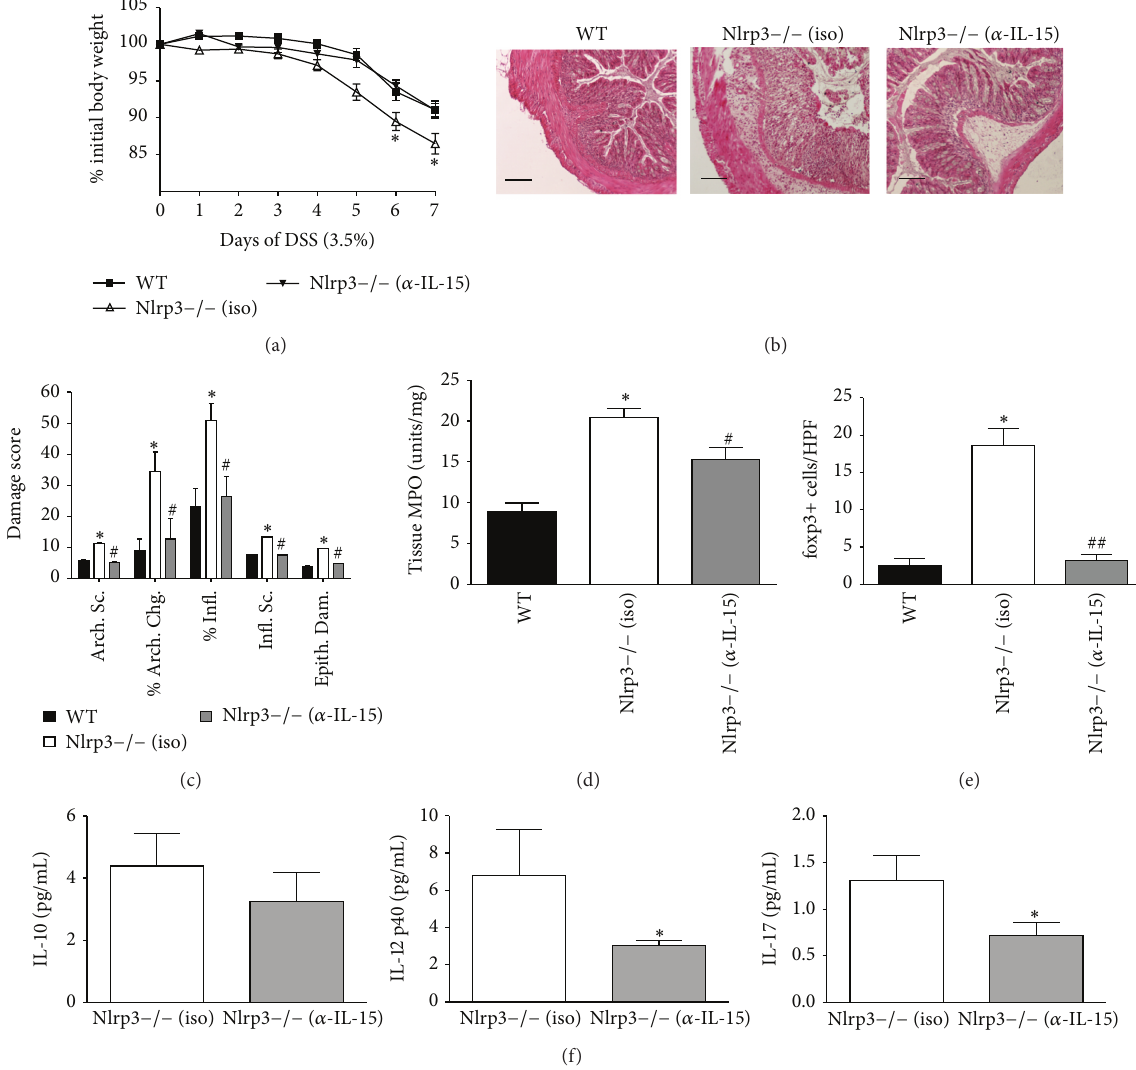
Figure 5: A neutralizing anti-IL-15 antibody normalizes the sensitivity of Nlrp3 − / − mice to DSS and reduces colonic IL-17 expression. (a) Changes in body mass in WT mice, Nlrp3 − / − mice treated with 5 𝜇 g IgG isotype (iso) control, or Nlrp3 − / − mice treated with an anti-IL-15 ( 𝛼 -IL-15) antibody through a 7-day course of DSS (3.5% w/v). ∗ denotes 𝑝 < 0.05 compared to WT and Nlrp3 − / − 𝛼 -IL-15; 𝑛 = 8 /group. (b) Representative hematoxylin and eosin stained colonic sections (scale bar = 100 microns) and (c) blind assessment of tissue damage and inflammation in WT mice, Nlrp3 − / − mice treated with 5 𝜇 g IgG isotype (iso) control, or Nlrp3 − / − mice treated with an anti-IL-15 ( 𝛼 -IL-15) antibody on day 7 of DSS. ∗ denotes 𝑝 < 0.05 compared to WT mice; # denotes 𝑝 < 0.05 compared to Nlrp3 − / − mice treated with the IgG isotype control antibody; 𝑛 = 8 /group. (d) Assessment of colonic tissue MPO levels and (e) colonic foxp3+ cells/HPF in WT mice, Nlrp3 − / − mice treated with an IgG isotype (iso) control antibody, and Nlrp3 − / − mice treated with a neutralizing anti-IL-15 ( 𝛼 -IL-15) antibody on day 7 of DSS. ∗ denotes 𝑝 < 0.05 compared to WT mice; # denotes 𝑝 < 0.05 compared to Nlrp3 − / − mice treated with the IgG isotype control antibody; ## denotes 𝑝 < 0.005 compared to Nlrp3 − / − mice treated with the IgG isotype control antibody; 𝑛 = 8 /group. (f) The expression of IL-10, IL-12p40, and IL-17 in colonic tissue isolated from Nlrp3 − / − mice treated with an IgG isotype (iso) control antibody and Nlrp3 − / − mice treated with a neutralizing anti-IL-15 ( 𝛼 -IL-15) antibody on day 7 of DSS. ∗ denotes 𝑝 < 0.05 compared to Nlrp3 − / − mice treated with an IgG isotype (iso) control antibody; 𝑛 = 8